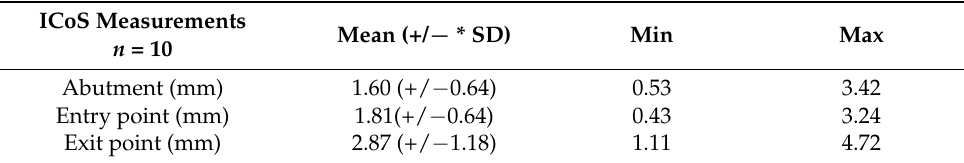
Table 2. Accuracy data. Result of the post-operative analysis of the implant coordinate system (ICoS) measurements. * SD, standard deviation.